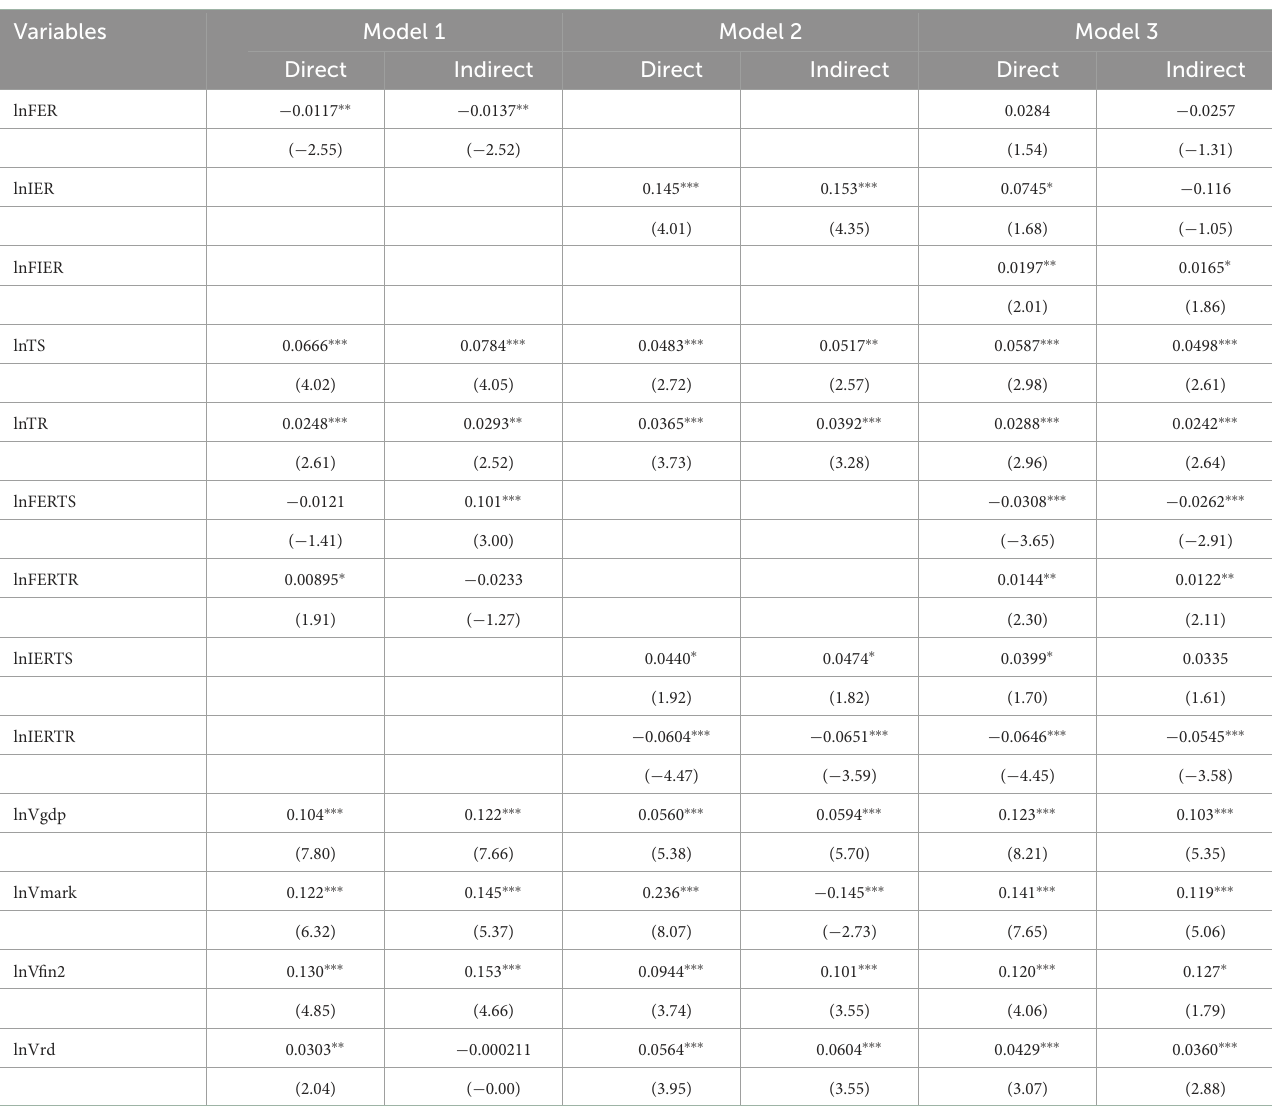
TABLE 8 Robustness